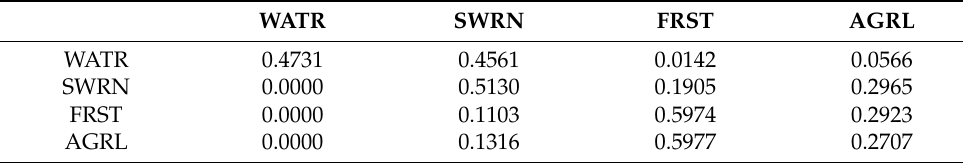
Table 3. Transition probabilities matrix for the year